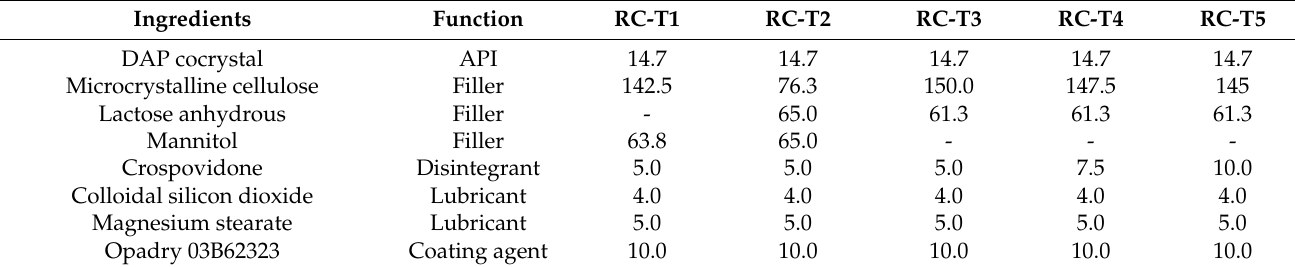
Table 2. Formulation compositions (mg) of the DAP cocrystal-loaded tablet via RC process.